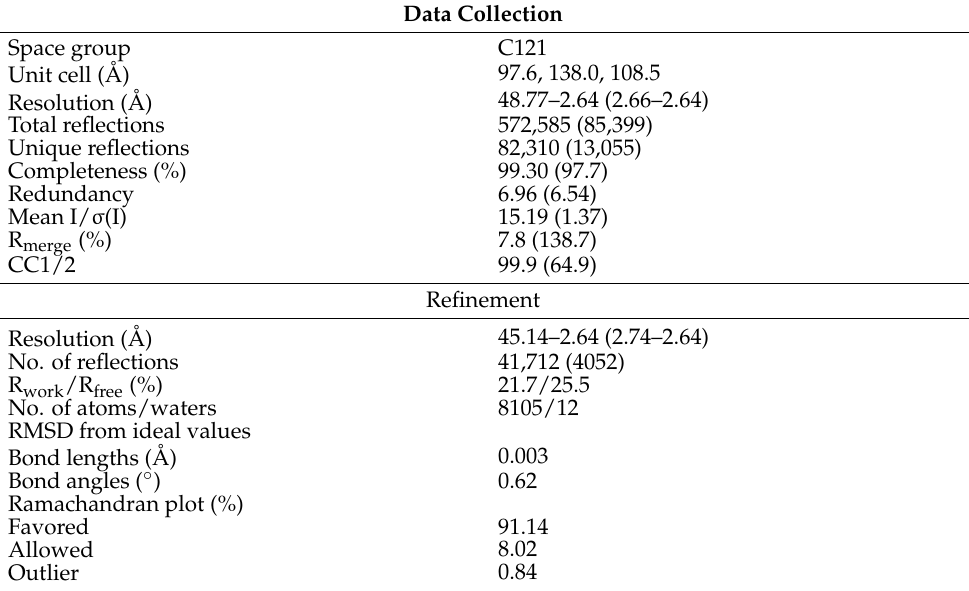
Table 3. Data collection and refinement